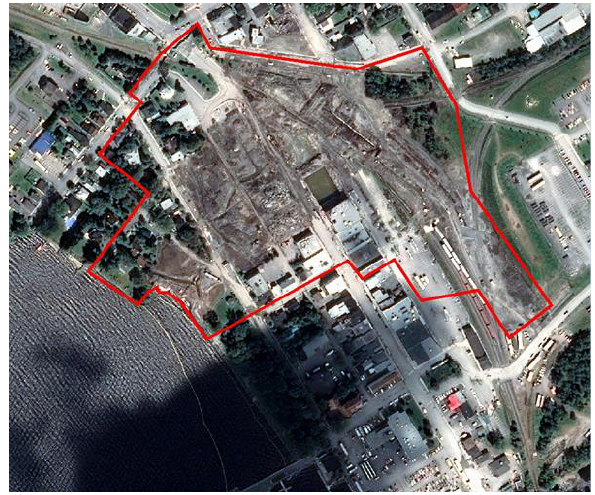
Figure 8. Pléiades image acquired over a month post derailment on August 15, 2013. © CNES 2013, Distribution Airbus DS